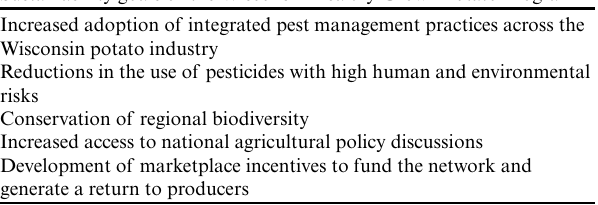
Table 1 . Early participants in the Wisconsin Healthy Grown agricultural network developed a shared vision that was translated into five sustainability